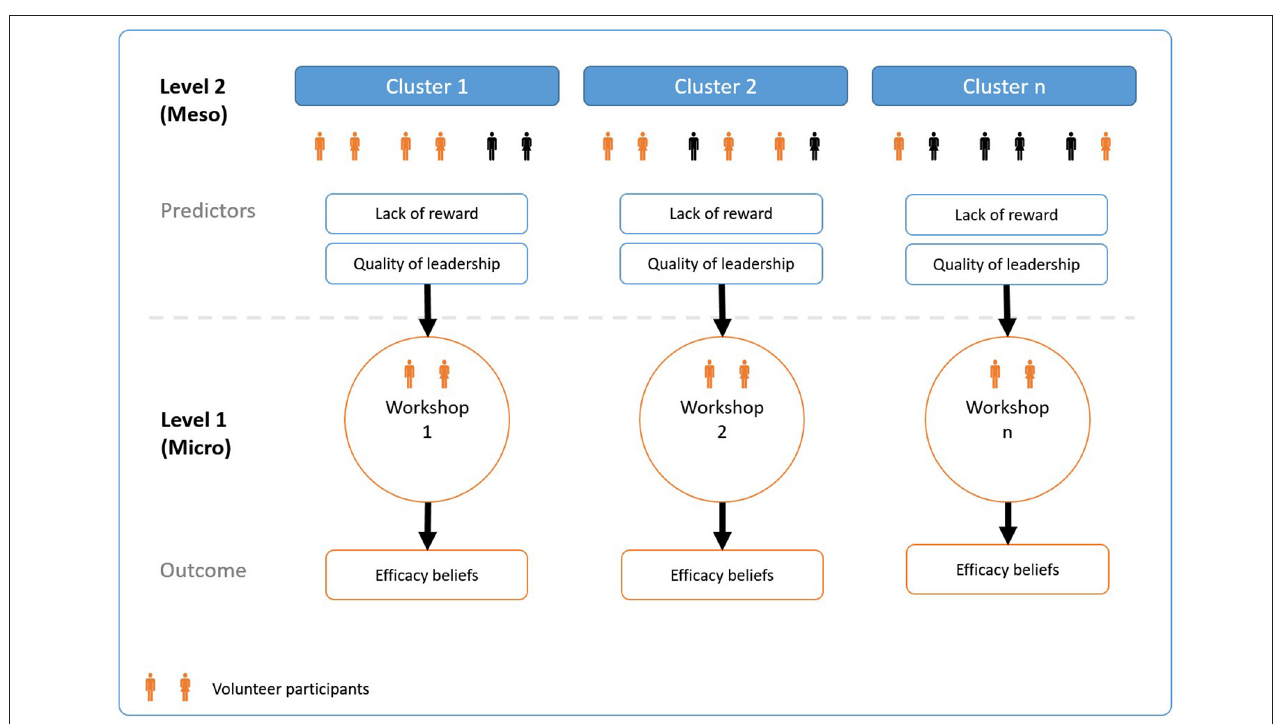
FIGURE 1 | Classification graph for the multilevel context of participative intervention groups.